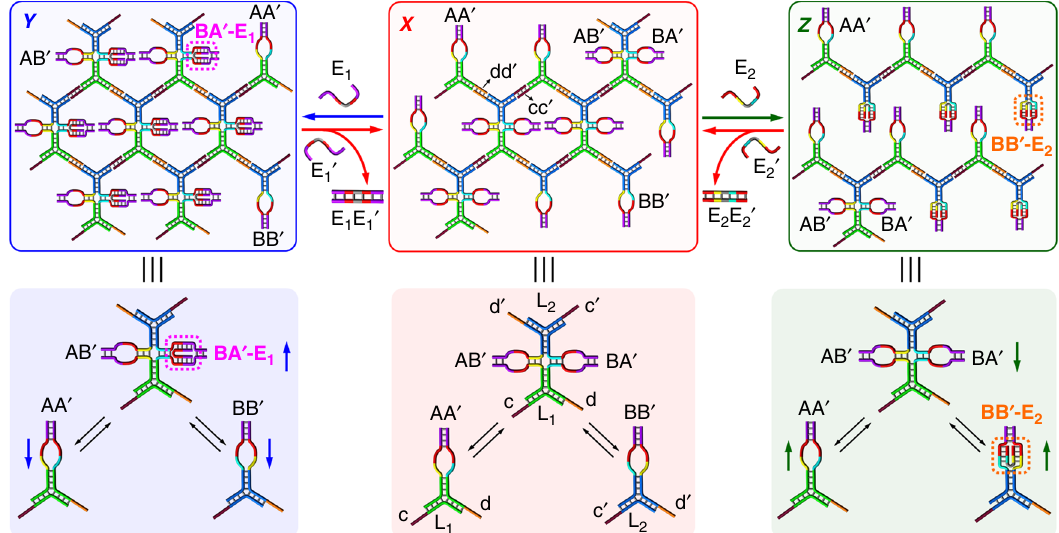
Fig. 1 Schematic control over the compositions and stiffness of hydrogels guided by constitutional dynamic networks. The CDN hydrogel of medium stiffness, X, is formed by the crosslinking of the toehold-modi fi ed constituents AA ’ , BB ’ , AB ’ , and BA ’ . The E 1 -guided stabilization of BA ’ in CDN hydrogel X leads to the reequilibration of hydrogel X to hydrogel Y with an enhanced stiffness due to the triggered increase of the tetradentate crosslinking unit AB ’ / BA ’ . The E 2 -guided stabilization of BB ’ in CDN hydrogel X leads to the transition of hydrogel X to Z exhibiting a lower stiffness due to the triggered depletion of the tetradentate crosslinking unit AB ’ /BA ’ . Subjecting the resulting hydrogel Y or Z to the counter trigger E 1 ’ or E 2 ’ , respectively, regenerates the original hydrogel